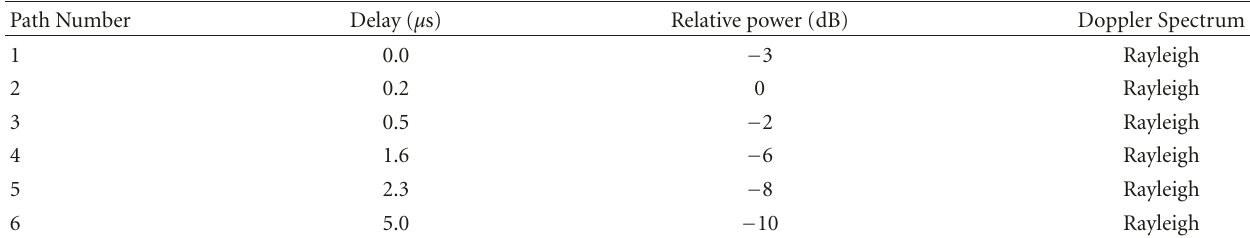
Table 5: Channel